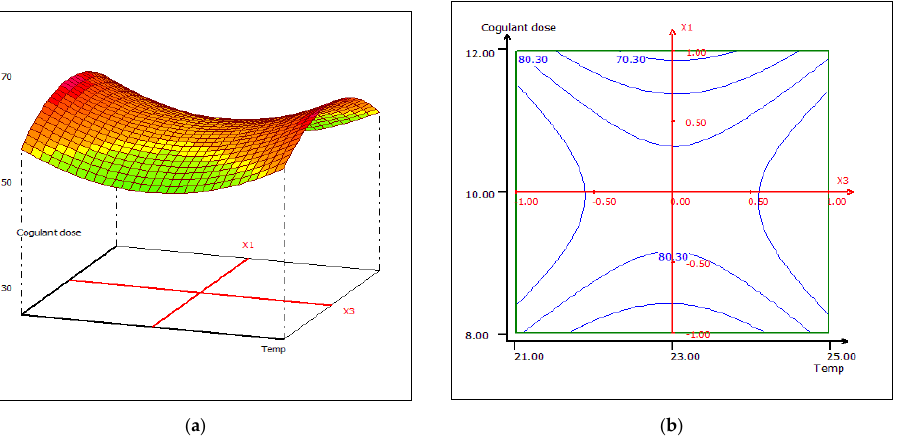
Figure 24. Three-dimensional ( a ) and two-dimensional ( b ) response surface plots for the COD of the treated food wastewater as a function of temperature and pH, when the coagulant dose was maintained at 10 mL.